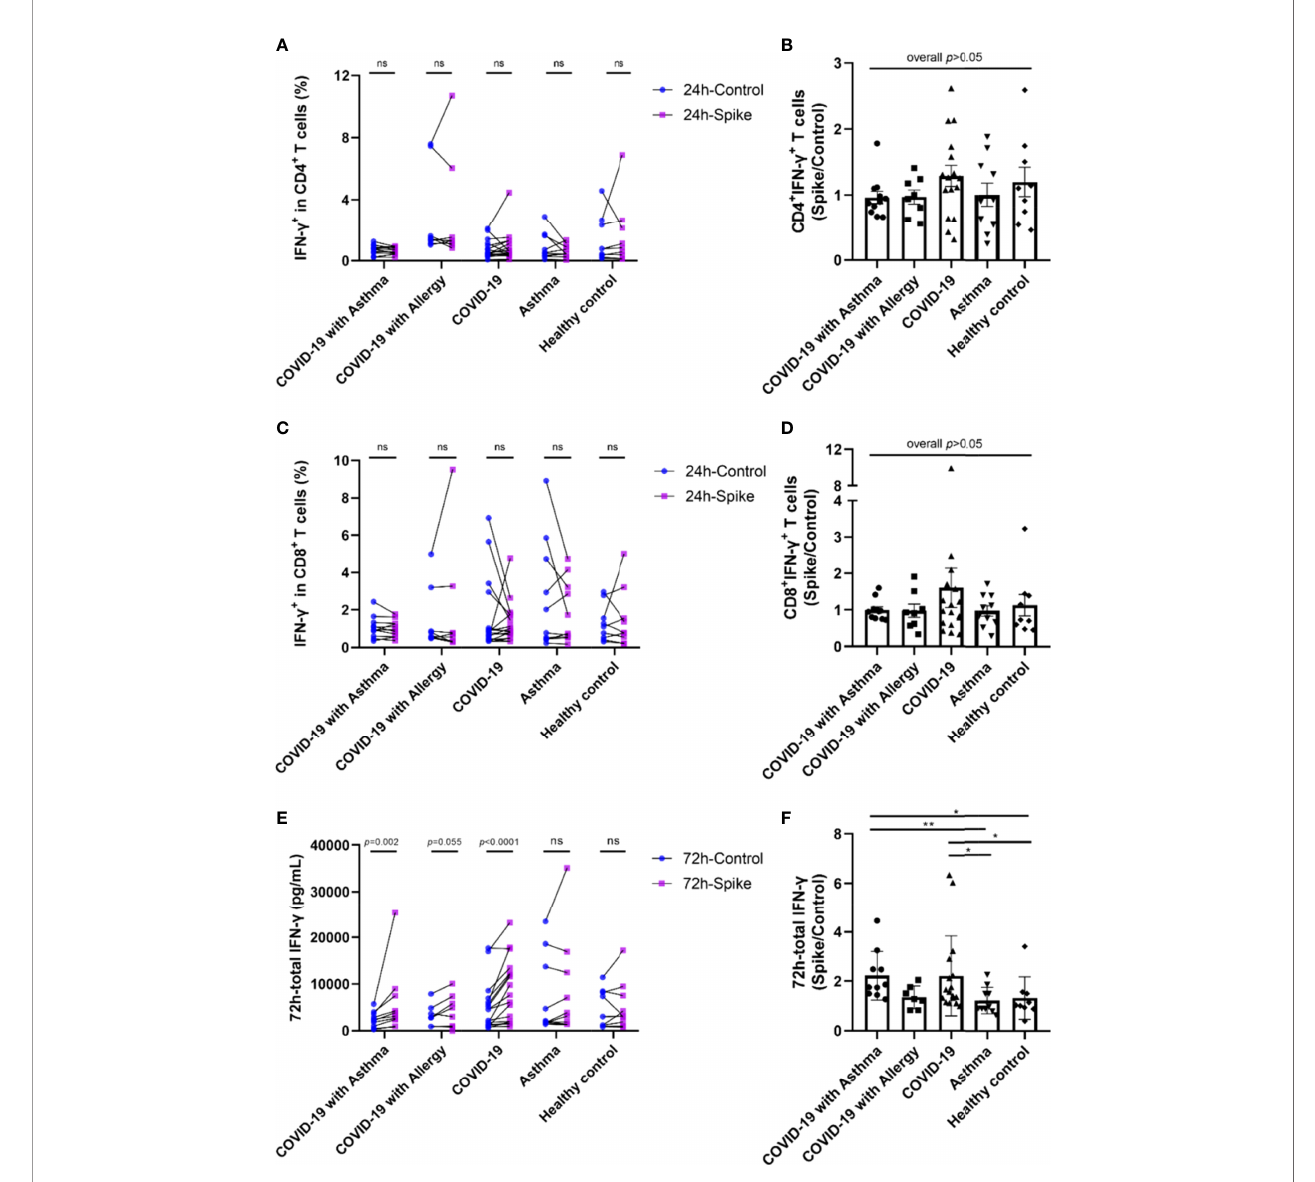
FIGURE 2 | SARS-CoV-2-speci fi c memory T cell responses among COVID-19 survivors and controls. PBMCs were stimulated with SARS-CoV-2 Spike peptide pools or PBS control. (A, C) IFN- g positive ratio of CD4 + T cells and CD8 + T cells against spike peptide pools or PBS control were detected by intracellular cytokine staining (ICS) and fl ow cytometry method. (E) IFN- g in the supernatant of total T cells culture measured by ELISA. (B, D, F) The ratio of speci fi c T cell response by spike peptide pools stimulation compared with PBS control. Each point on the graph represents a single donor. Control and spike peptide pools stimulation groups were compared using Wilcoxon matched-pairs signed rank test. The signi fi cance between each group was determined using the Kruskal-Wallis test and Dunn ’ s multiple comparison test. ICS, intracellular cytokine staining. * p < 0.05, ** p < 0.01, *** p < 0.001, ns, not signi fi